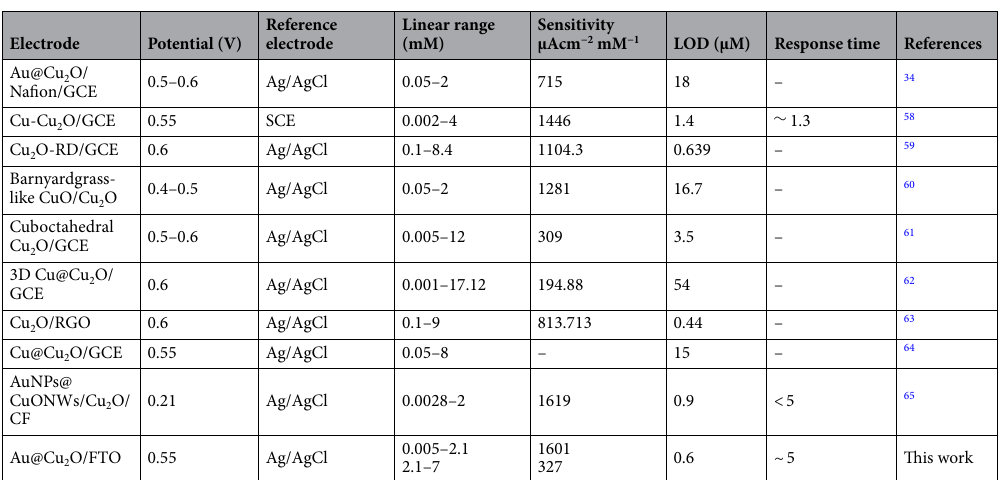
Table 1. Comparison of electrochemical performance of recently reported non-enzymatic glucose sensor. GCE: glassy carbon electrode; CPE: carbon paste electrode; RD: rhombic dodecahedral; RGO: reduced graphene oxide; NPs: Au nanoparticles; NWs: nanowires; CF: copper foam.